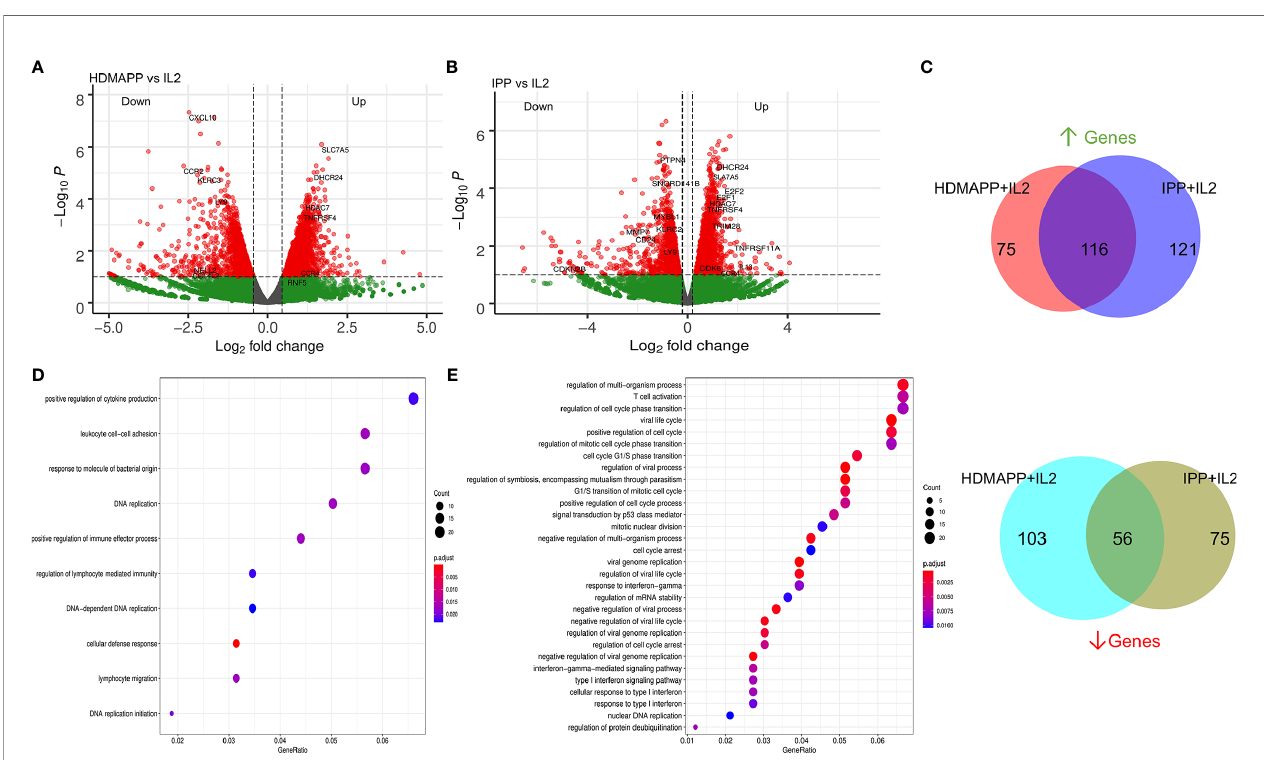
FIGURE 2 | Transcriptional dynamics upon phosphoantigen-driven activation of gd T cells. (A) Differential gene expression of HDMAPP + IL2 vs. IL2 treatment was performed showing key labels above a selected cutoff range. (n = 3). (B) Volcano plot for IPP + IL2 treatment compared for DGE over IL2 (n = 3). (C) Differentially regulated genes for HDMAPP + IL2 over IL2 and IPP + IL2 over IL2 with FDR < 0.05 were segregated in up- and downregulated genes for each treatment pair. Venn diagrams were plotted for common up- and downmodulated genes comparing both the phosphoantigen conditions. (D, E) Enrichment dot plots for HDMAPP + IL2 over IL2 and IPP + IL2 over IL2 treatments, showing most signi fi cantly enriched GO